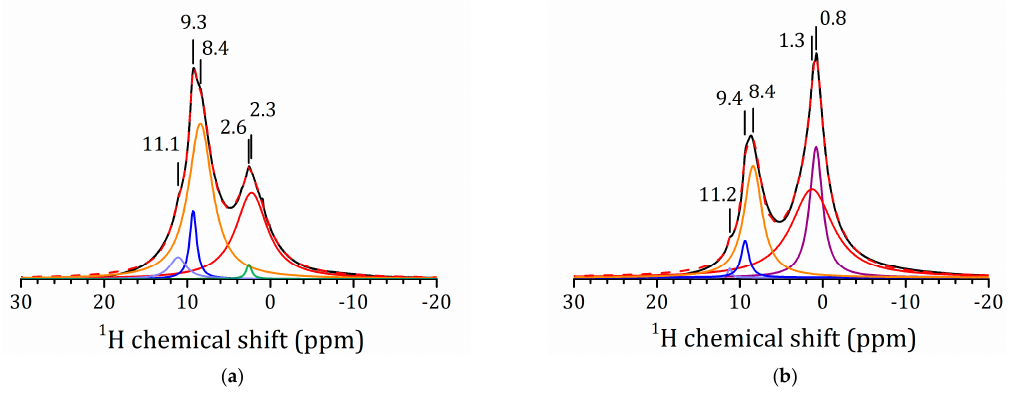
Figure 8. 1 H MAS NMR spectra of HLT 3 × MeNH 2 ( a ) and HLT 3 ( b ) and their decomposition. Dashed lines show the total fit.